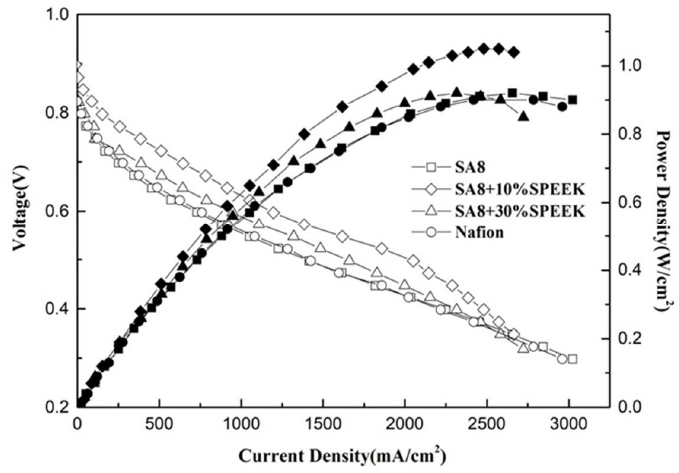
Figure 19. The morphology diagram of SA8 blended with PEG.